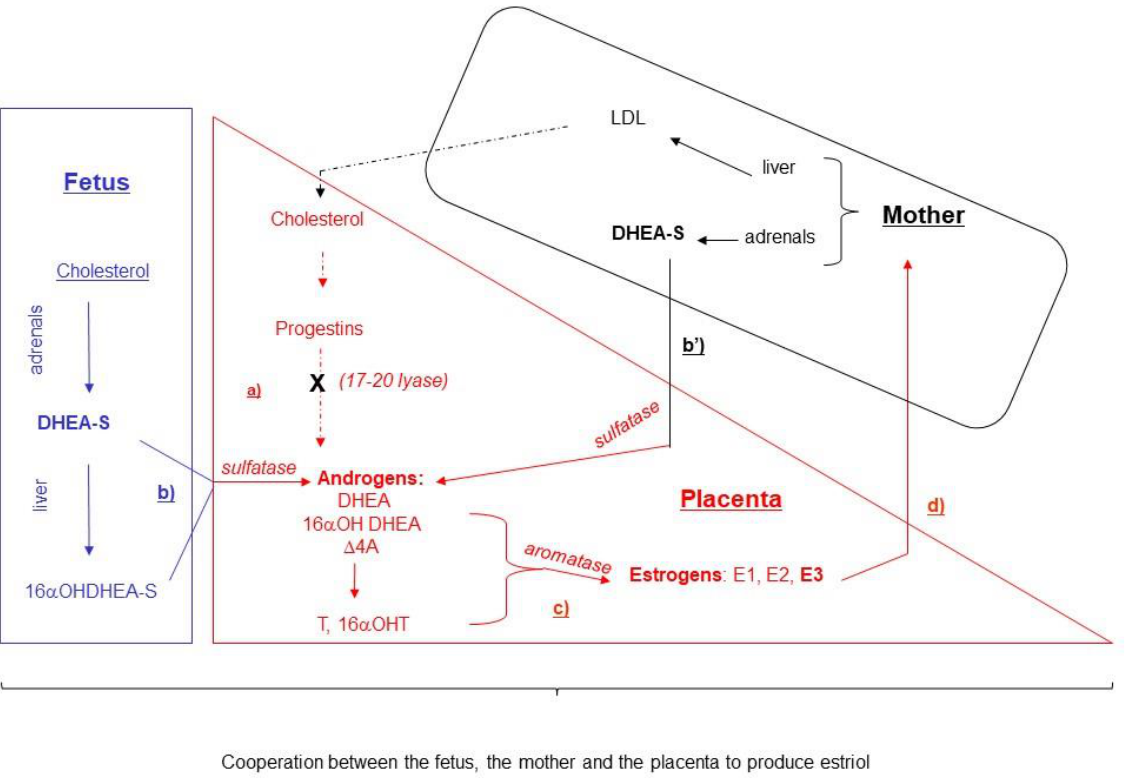
Figure 5. Synthesis and secretion of estriol during pregnancy. The human placenta lacks cytochrome P450 17alpha-hydroxylase-17:20 lyase, which is required to convert progestins into androgens (a). Thus, the placenta participates in the enzymatic conversion of fetal 16α-OH-DHEA-S, DHEA-S (b), and the maternal DHEA-S (b’) into E3, by sulfatase (STS), and aromatase activities (c). Estrogens diffuse into both the fetal and maternal compartments (d). estriol (E3), estradiol (E2), estrone (E1), dehydroepiandrostenedione (DHEA), sulfate of dehydroepiandrostenedione (SDHEA), delta 4 an- drostenedione (Δ4A).